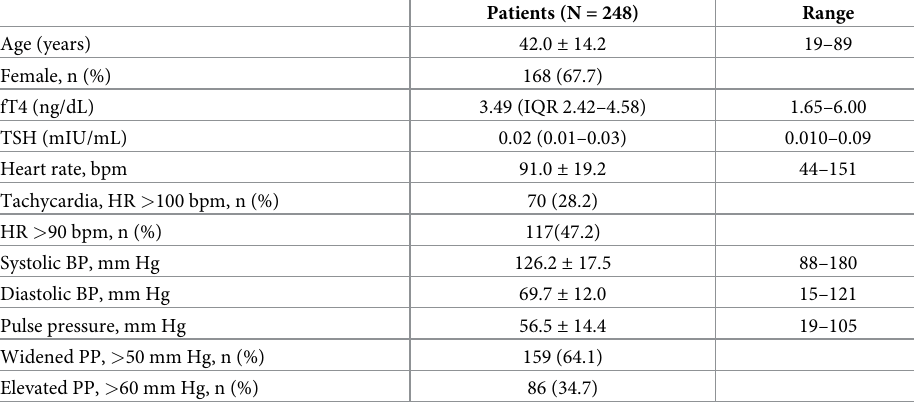
Table 1. Clinical characteristics of the study